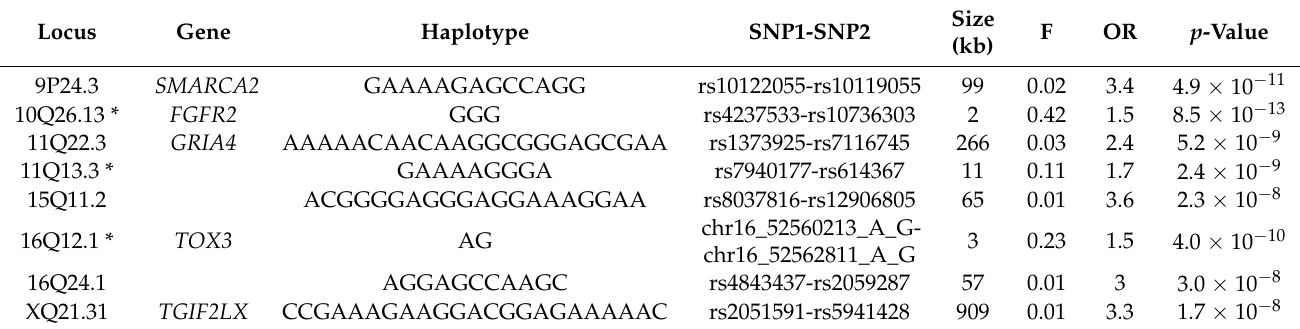
Table 1. Haplotypes with lowest p -value in eight familial breast cancer risk loci.